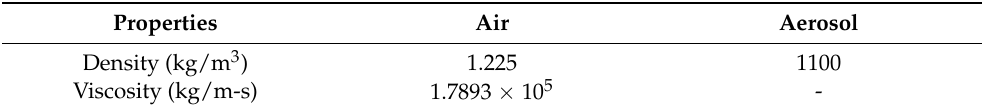
Table 1. Properties of air and